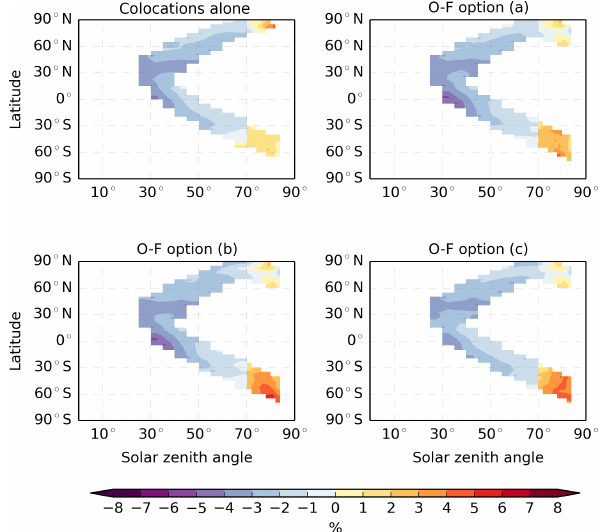
Figure 5. Time mean total column ozone biases (%) between GOME-2A and OMI-TOMS for July–August 2014 from coloca- tion alone and for the options (a) , (b) , and (c) of Sect. 4.2 that use observation-minus-forecast differences. For options (a) , (b) , and (c) , the forecasts were taken from the “OMI” assimilation run (see Table 5). The bias in the “colocations alone” panel was computed using the thinned observation data set (as opposed to Figs. 2 and 3 that used the unthinned data set) to compare to the other cases that use thinned observations. The colours blue to purple denote negative differences and the colours yellow to red refer to positive differences.